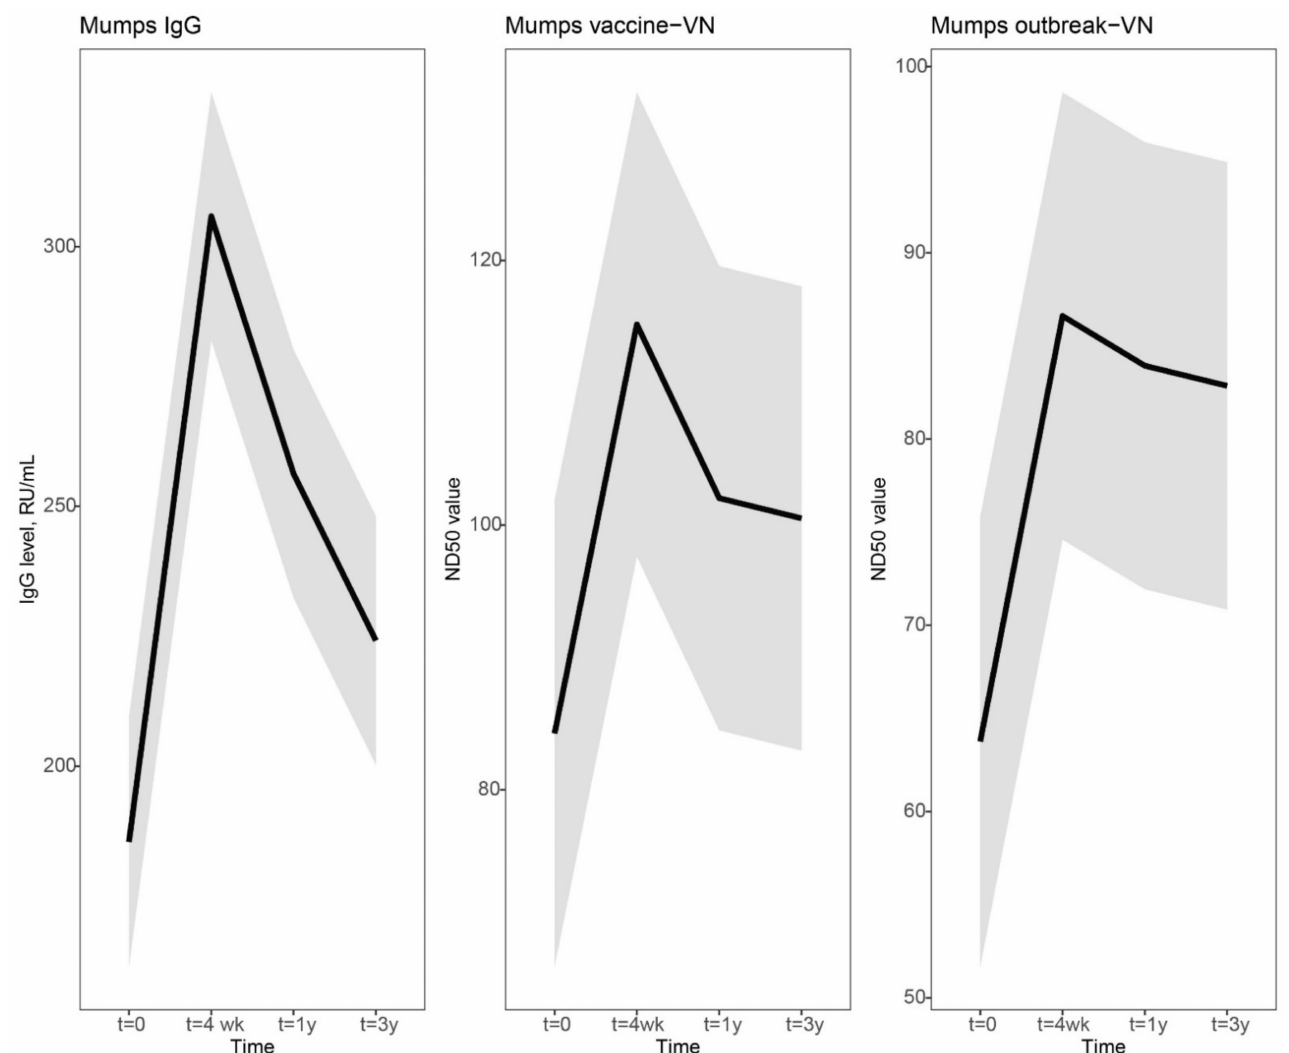
Figure 1. Dynamic course of IgG and virus neutralizing antibody responses to mumps virus after a third measles-mumps-rubella vaccine dose. We used a linear mixed model to compare the dynamics in IgG and virus neutralizing antibody responses to mumps virus after a third measles-mumps- rubella vaccine dose. Fitted averaged dynamic course of antibody levels, based on the results of the model fit, are presented as bold lines. Mumps virus-specific IgG concentrations in RU/mL (left), virus neutralizing antibodies (VN) in ND50 values of focus-reduction neutralization test against mumps vaccine strain (middle), and mumps outbreak strain (right) prior to, and 4 weeks, 1 year and 3 years following an MMR3 dose. Abbreviations: IgG level, mumps virus-specific IgG concentration; RU/mL, RIVM units per milliliter; VN, virus neutralizing antibodies; ND50 values, virus-neutralizing antibody titer which resulted in 50% plaque reduction; t = 4 wk, four weeks after a third dose of measles-mumps-rubella vaccine dose (MMR3); t = 1 y and t = 3 y, resp. 1 year and 3 years after an MMR3